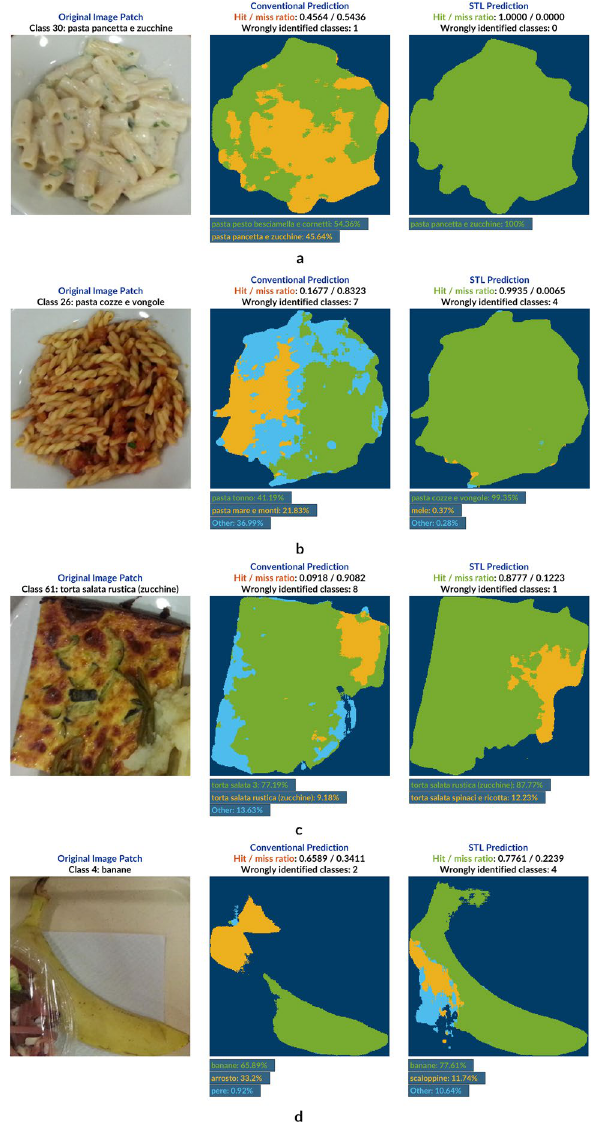
Figure 5. U-Net model predictions of UNIMIB2016 test set. Example prediction results of a test image patch (left) given by a conventionally trained network (middle) and a sequentially trained one (right)—hit/miss ratios are defined on pixel-level. The color-coding of names of recognized classes corresponds to those colors shown in the achieved segmentations. In case of more than 3 identified categories, only the two ones with highest prediction response are mentioned by name whereas the rest is summarized as Other . ( a ) Example of a food class which was misinterpreted by the conventionally trained model with a 46% hit ratio as a visually highly correlated category. The STL approach leads to a definite elimination of this doubt, choosing the correct food class for all foreground pixels. ( b ) All pasta classes predicted by the two network models resemble each other to a very high degree as they all contain pasta tossed in tomato sauce differing in subtle details such a the addition of sea food, for example. While the number of falsely categorized pixels in the conventionally trained network model amounts to 7 including a very low hit value, prediction performance is significantly improved in the case of the STL prediction. ( c ) Similarly to 5b, training the network using STL results in a highly increased prediction definiteness with respect to visually akin dataset categories. While the results given in STL prediction are not flawless, the model is only considering one additional class besides the correct category, with the conventionally trained version remaining indecisive between 8 candidates. ( d ) Even in difficult and exceptional food serving conditions, the STL prediction clearly outperforms the conventional approach of training the